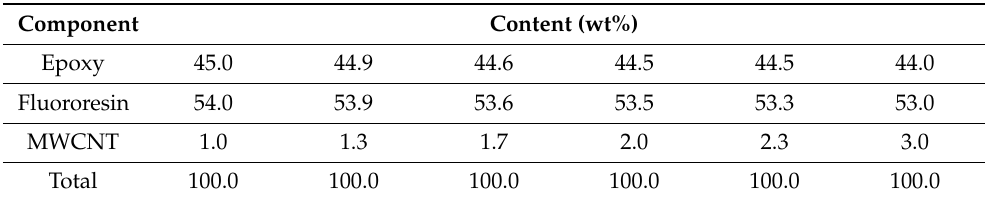
Table 1. MWCNT contents of solid lubricants.